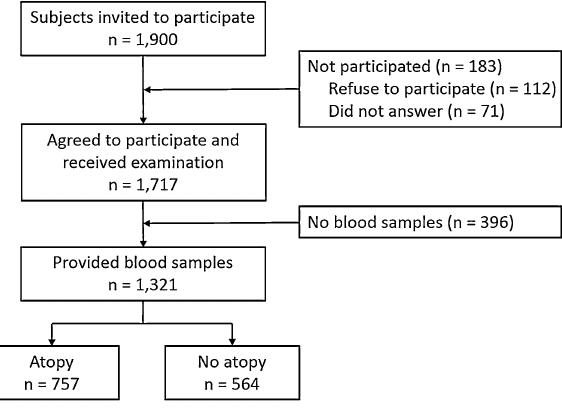
Figure 1. Schematic presentation of the recruitment process of the study